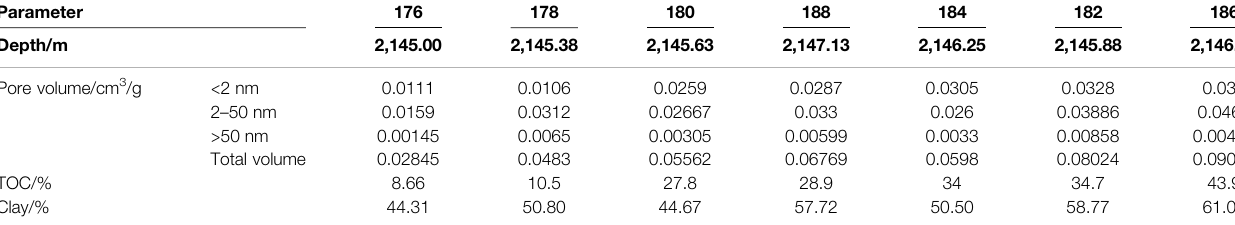
TABLE 1 | TOC content, clay mineral content, and volumes of micropores, mesopores, and macropores of Shan 23 shale. Parameter